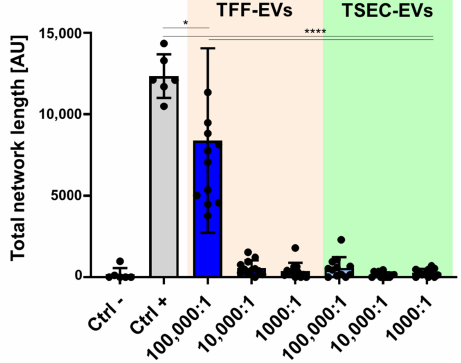
Figure A2. Loss of angiogenic potential of HPL-EVs after size-exclusion chromatography. Total length of the endothelial networks in the absence (white bar, negative control; grey bar, positive control) or presence of HPL-derived TFF-EVs and TSEC-EVs at EV:cell ratios of 100,000, 10,000 and 1000:1. TFF-EVs at the ratio of 100,000:1 were capable of inducing endothelial-cell network formation, whereas TSEC-EVs were not able to induce such effect at any given concentration. Mean ± SD of three independent experiments performed in quadruplicate. One-way ANOVA/Tukey, **** p ≤ 0.0001, * p ≤ 0.05.